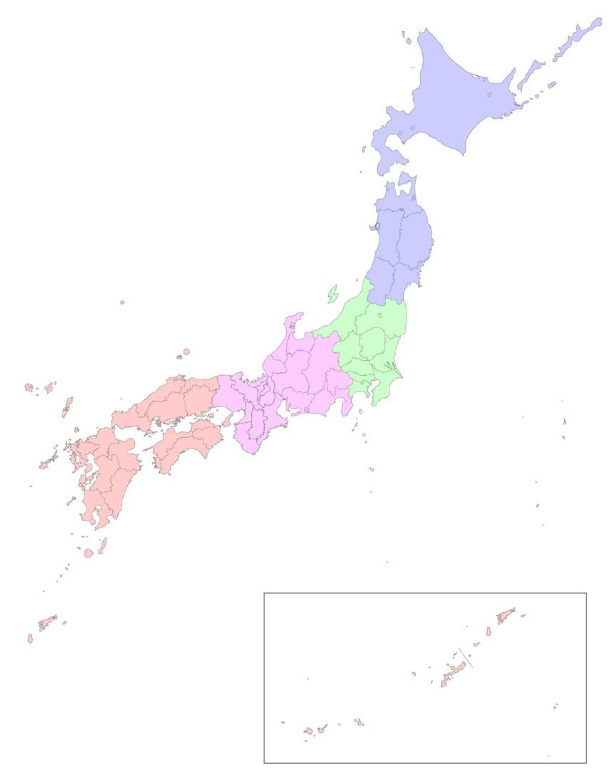
Figure 1. Four regions of Japan designated in the study. Japan was divided into four regions according to the locations: north (purple), central (green), west (pink) and south